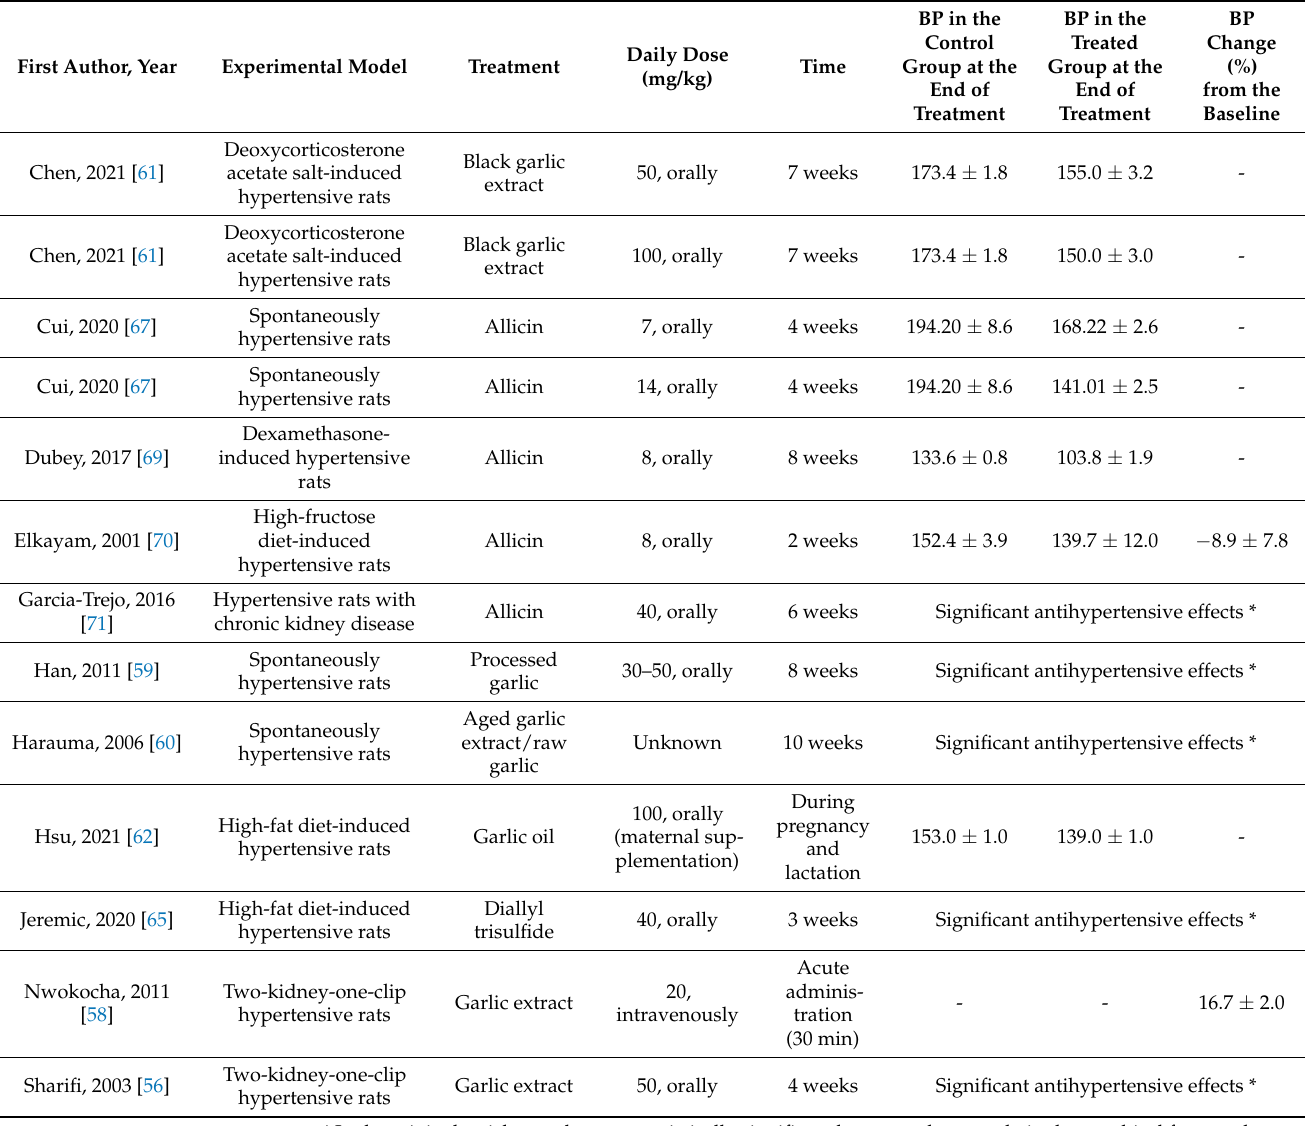
Table 1. Antihypertensive effects of garlic and garlic polysulfides in preclinical studies. Blood pressure (BP) values at the end of treatment were reported for studies evaluating the preventive effects of supplements against BP increase in hypertensive animals, while change (%) in BP was reported for studies directly evaluating the blood pressure-lowering effects of garlic or garlic polysulfides in animals with hypertension. All values refer to systolic BP (mmHg) reported as mean ±